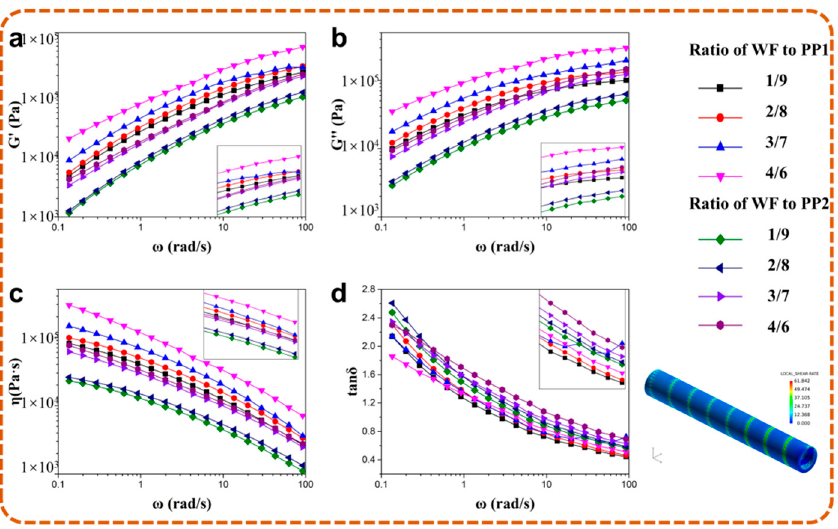
Figure 8. Storage modulus G ′ ( a ), loss modulus G ′′ ( b ), complex viscosity η ( c ) and loss tangent tan δ ( d ) of PP 1 and PP 2 based composites with different WF content.